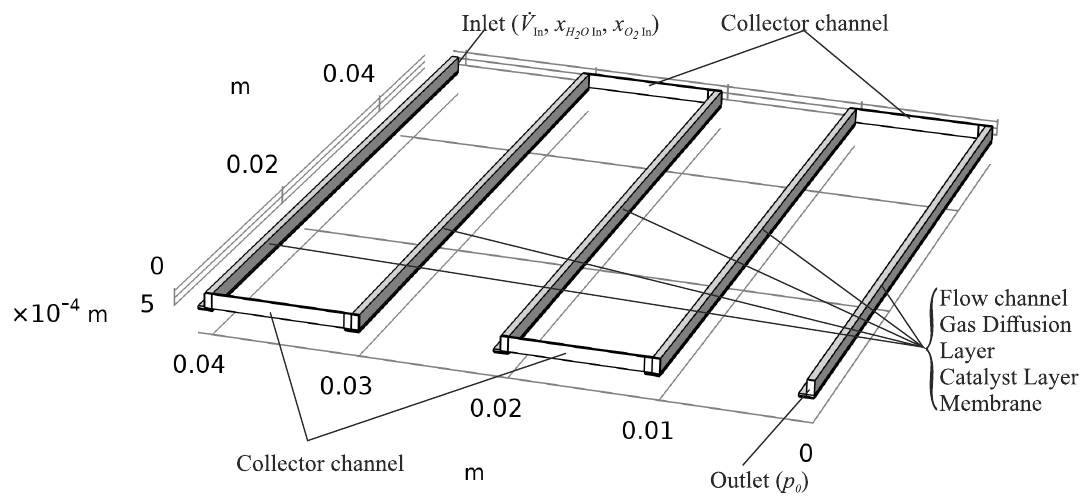
Figure 4. Reduced three-dimensional (3D)-geometry of the complete active cell area (see Figure 1), with five segments consisting of flow channel, gas diffusion layer (GDL), catalyst layer (CL) and membrane, connected by the collector